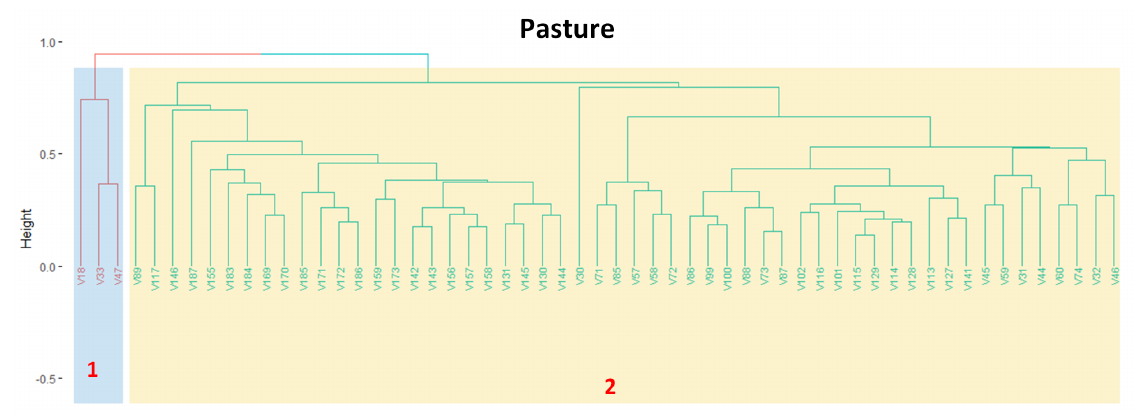
Figure 12. Dendrogram for pasture separated into two